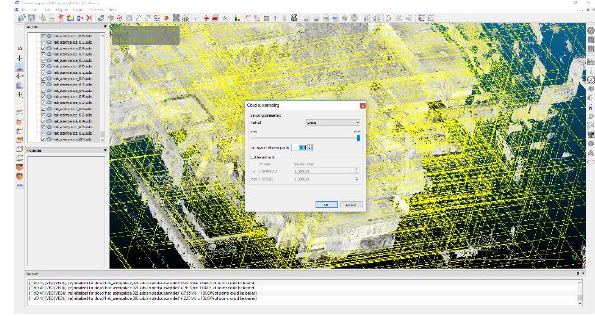
Figure 7. Al-‘Azm Palace – Using Cloud Compare to reduce point density